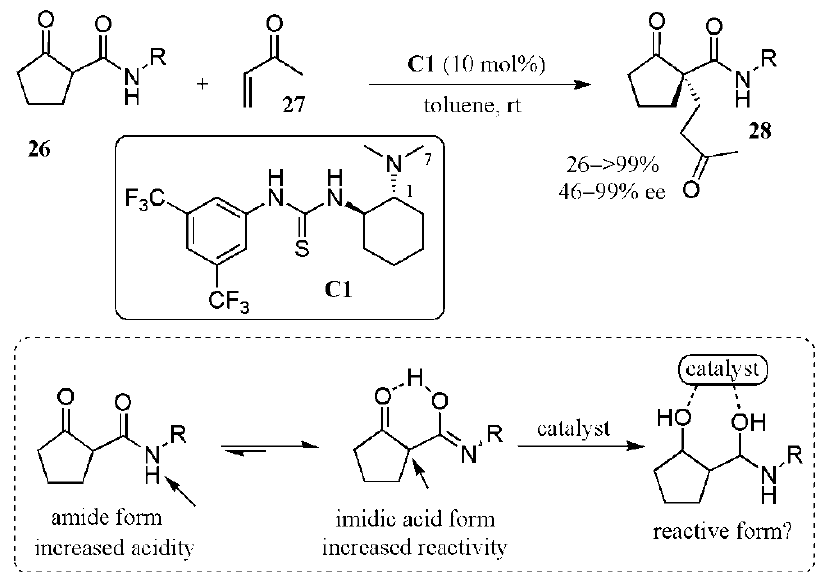
Figure 21. Michael additions of β -ketoamides to α , β -unsaturated carbonyl compounds, catalyzed by C1 [51].